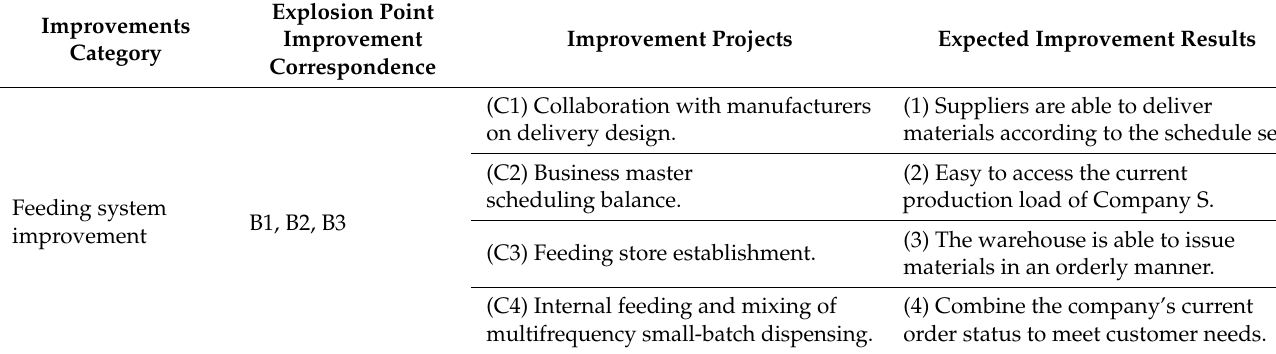
Table 4. Summary of the 10 improvement items and their improvement effects.